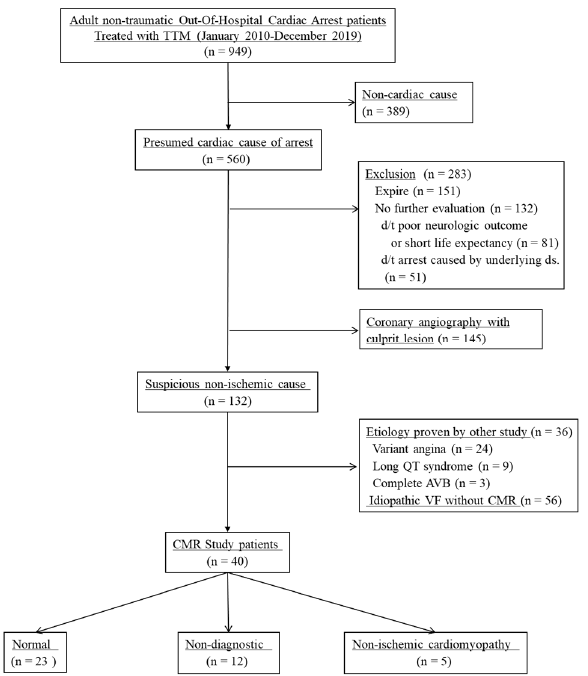
Figure 1. Patient enrolment flow diagram. TTM: Targeted temperature management; AVB: Atrioventricular block; VF: Ventricular fibrillation; CMR: Cardiac magnetic resonance.